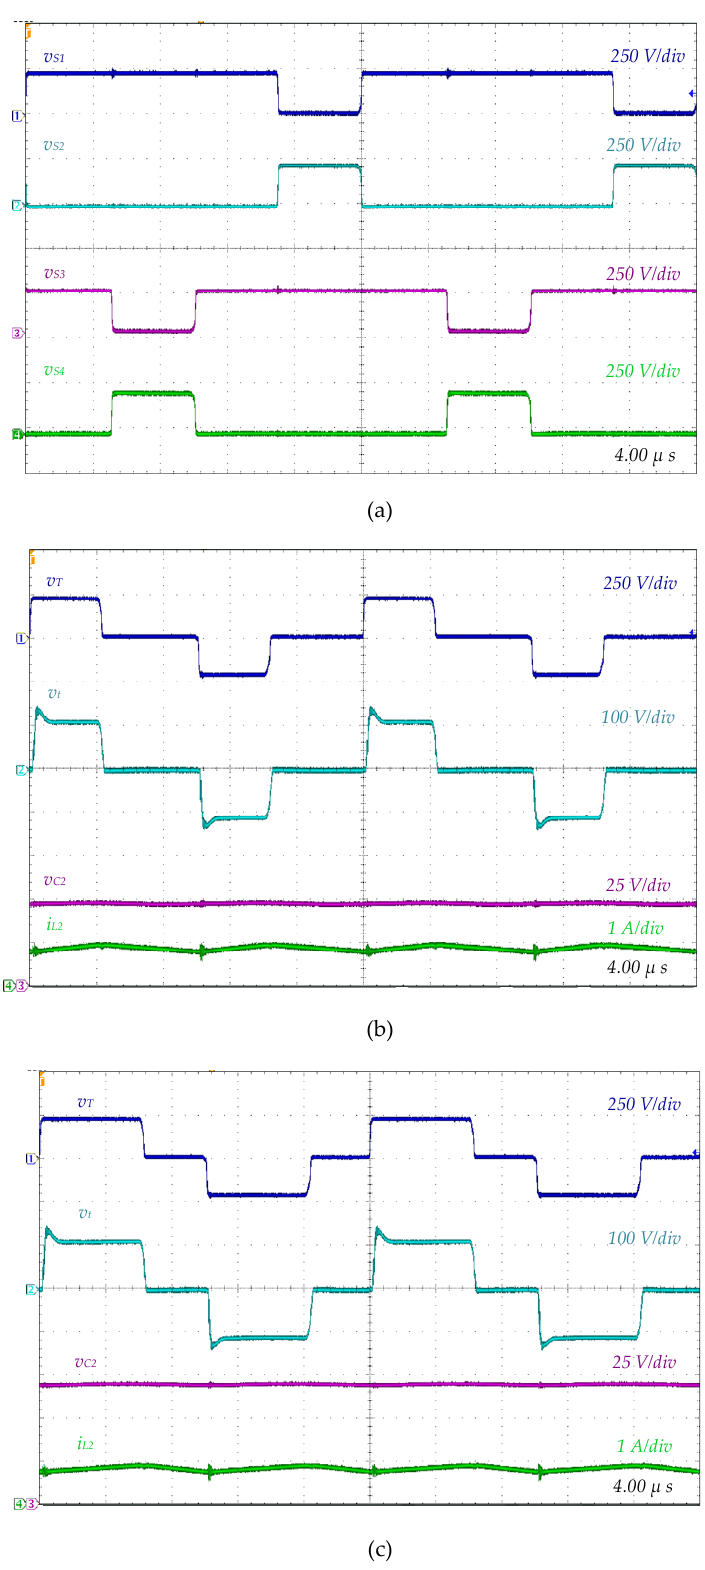
Figure 17. Steady-state operation of the converter operating in step-down mode: ( a ) Semiconductors’ voltage, transformer voltages ( v T , v t ), voltage ( v C2 ), and current ripple in the filters ( i L2 ) ( b ) for a duty-cycle equal to 0.48, ( c ) for a duty-cycle equal to 0.69.